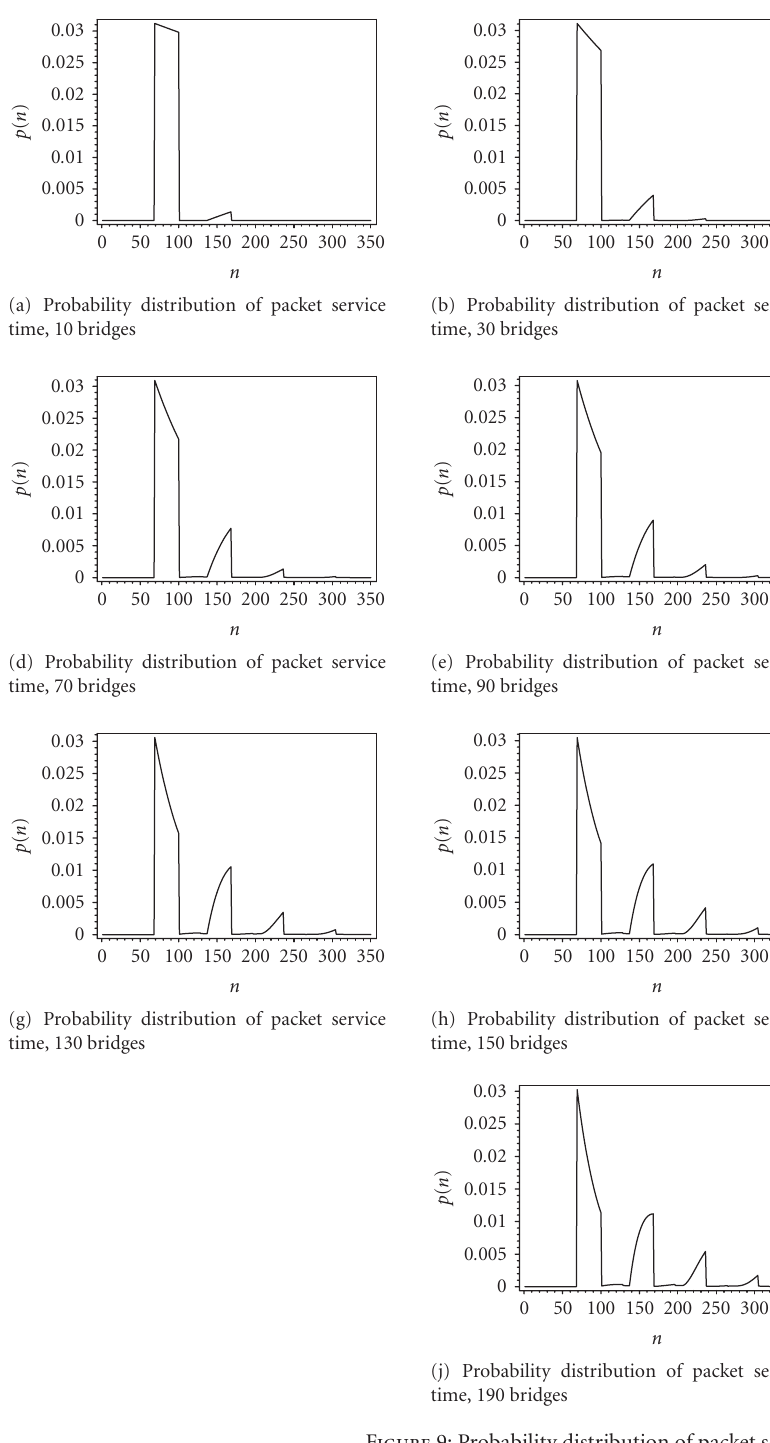
Figure 9: Probability distribution of packet service